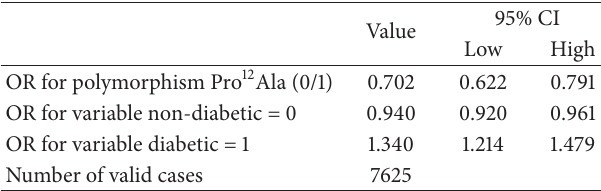
Table 8: Estimated risk of the Pro 12 Ala polymorphism with